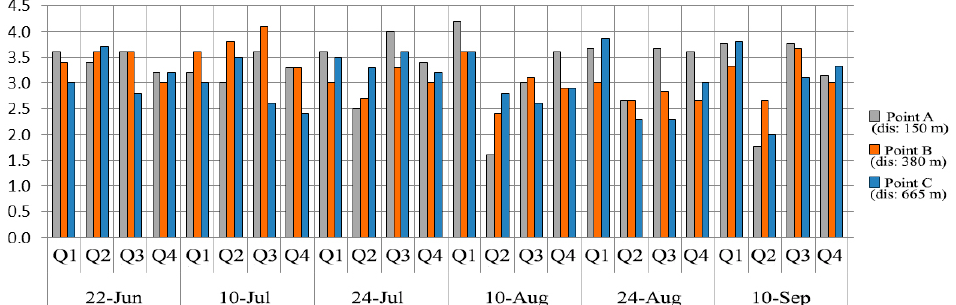
Figure 4. The average frequency of questionnaire data (Questions 1–4) at three intersections. Intersection A is gray, intersection B is orange and intersection C is blue. Table 4. Clothing and activity level of responders in the three investigated